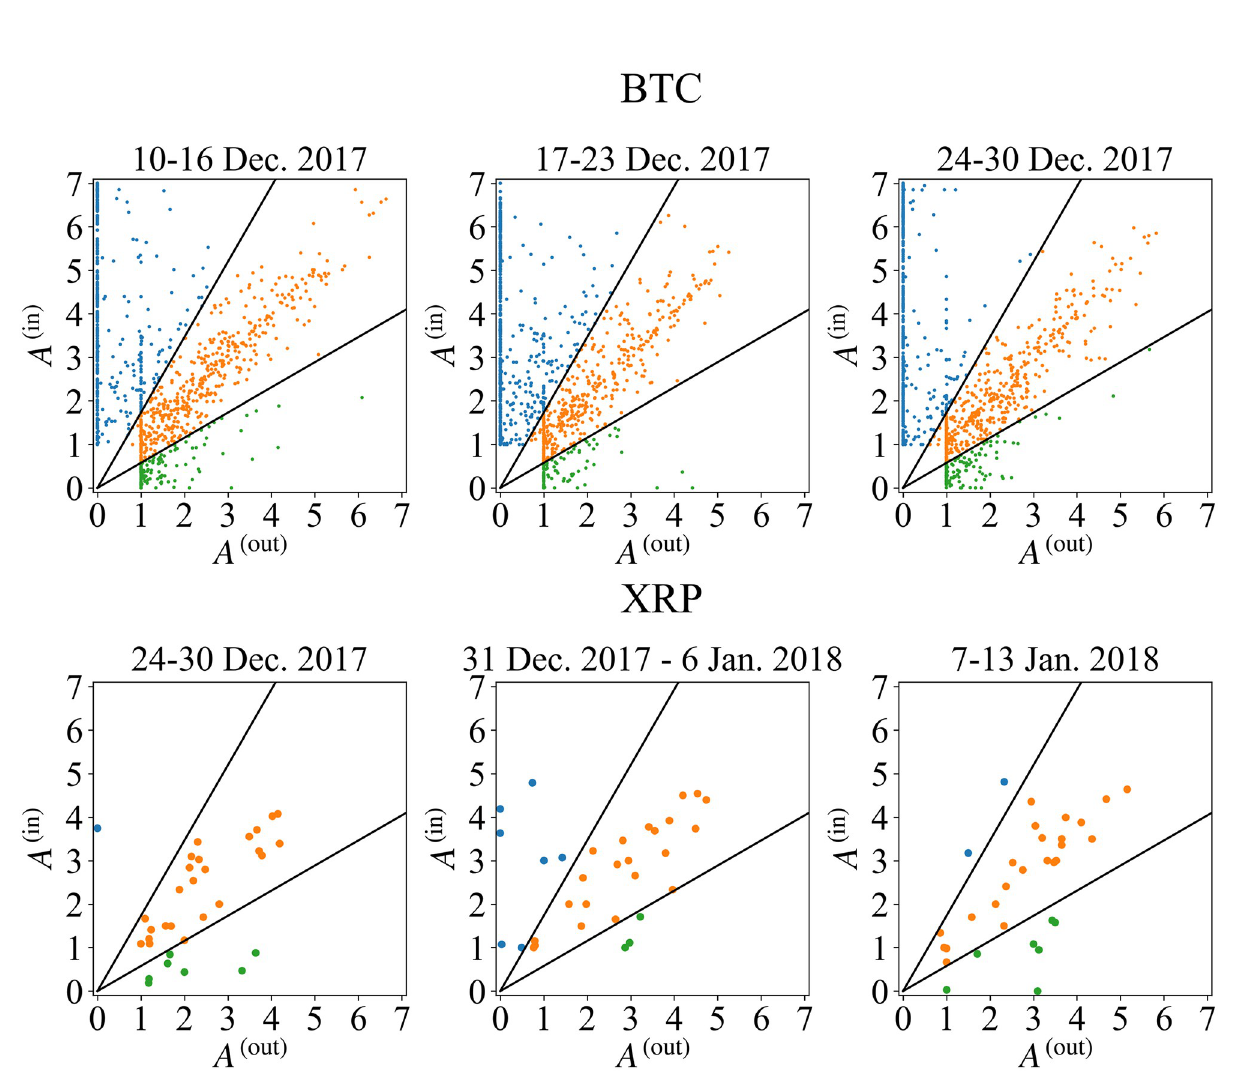
Fig 5. F-frequency for Bitcoin (top) and XRP (bottom) regular players around the peak price day. Blue, orange, and green points represent In-, Bal-, and Out-players, respectively. Black lines divide these regions.